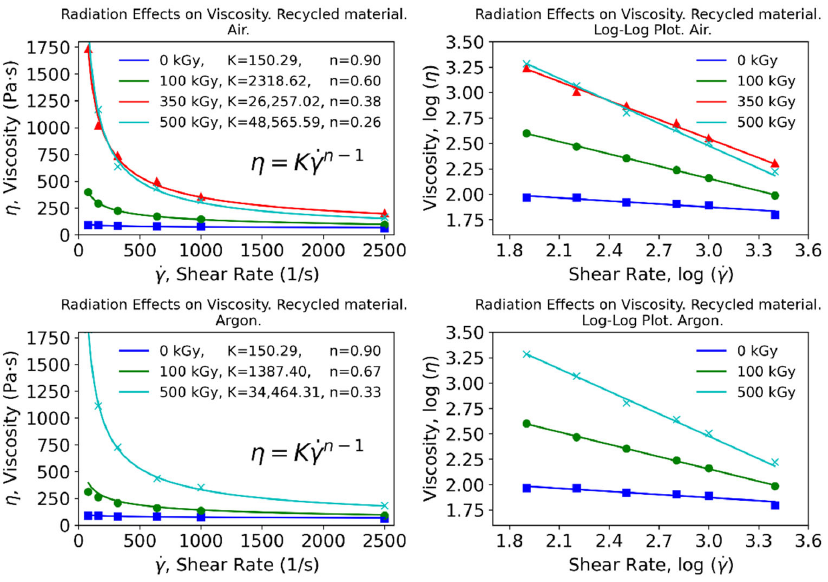
Figure 4. Apparent viscosity for recycled material at different absorbed doses. Top: irradiation in air. Bottom: inert atmosphere.